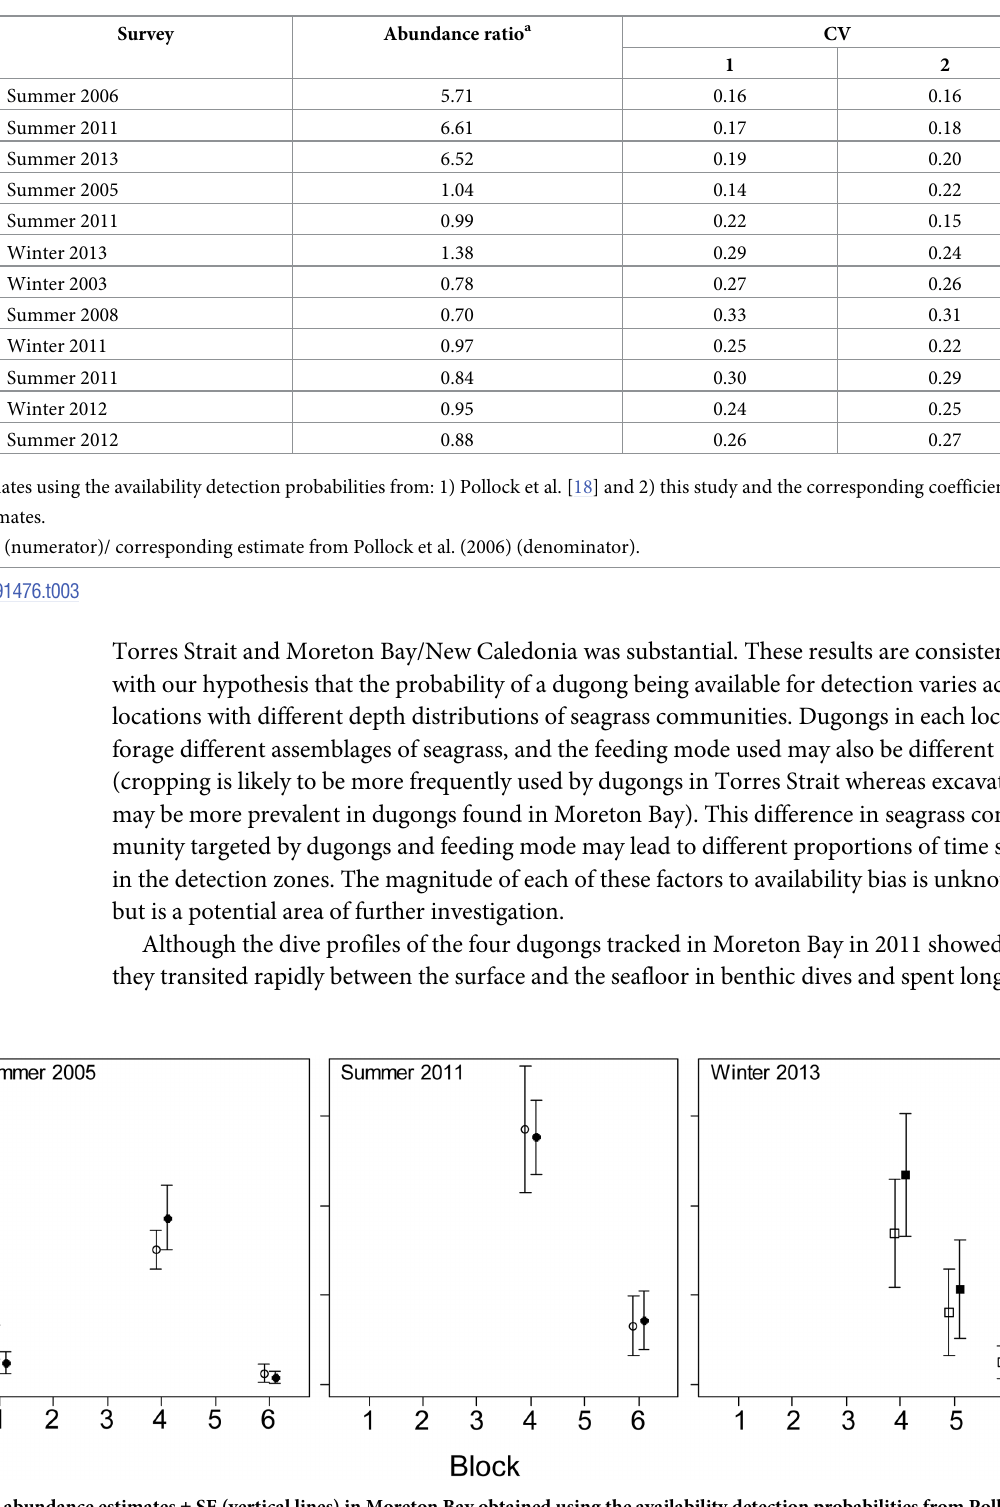
Fig 4. Population abundance estimates ± SE (vertical lines) in Moreton Bay obtained using the availability detection probabilities from Pollock et al. [18] (open squares) and this study (closed